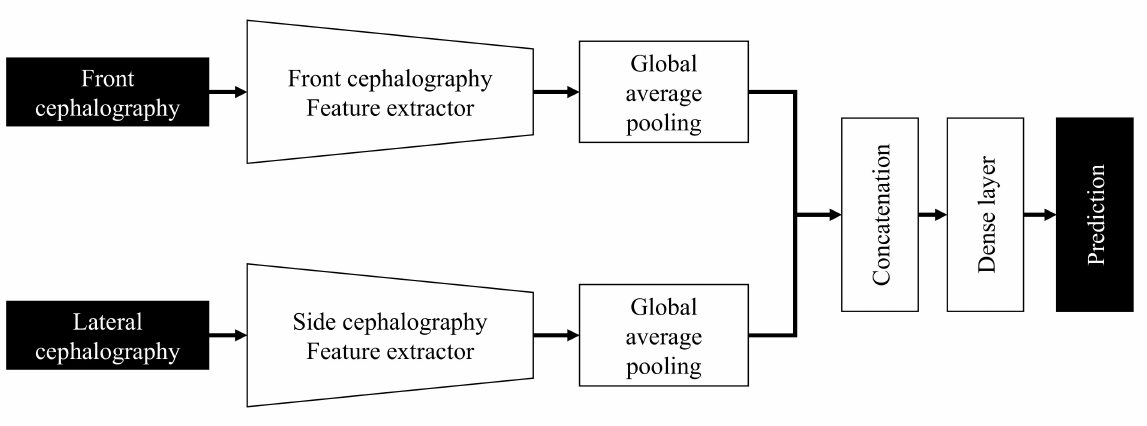
Figure 3. Multiside convolutional neural networks (CNNs) for classification using PA and lateral cephalometric